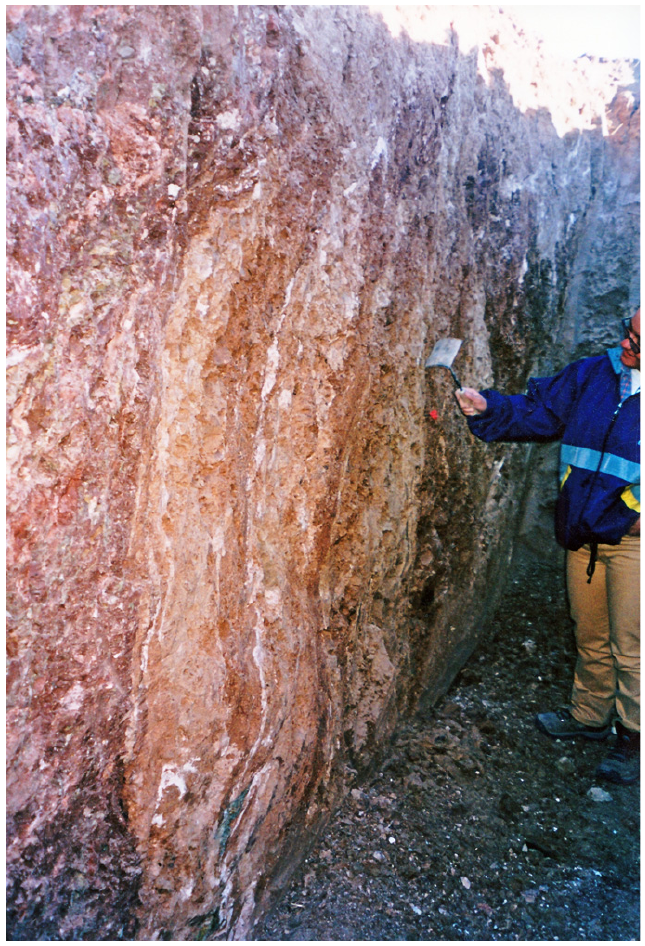
Figure 11. General view of Trench-4. Strongly sheared units and vertical sliding surfaces are seen